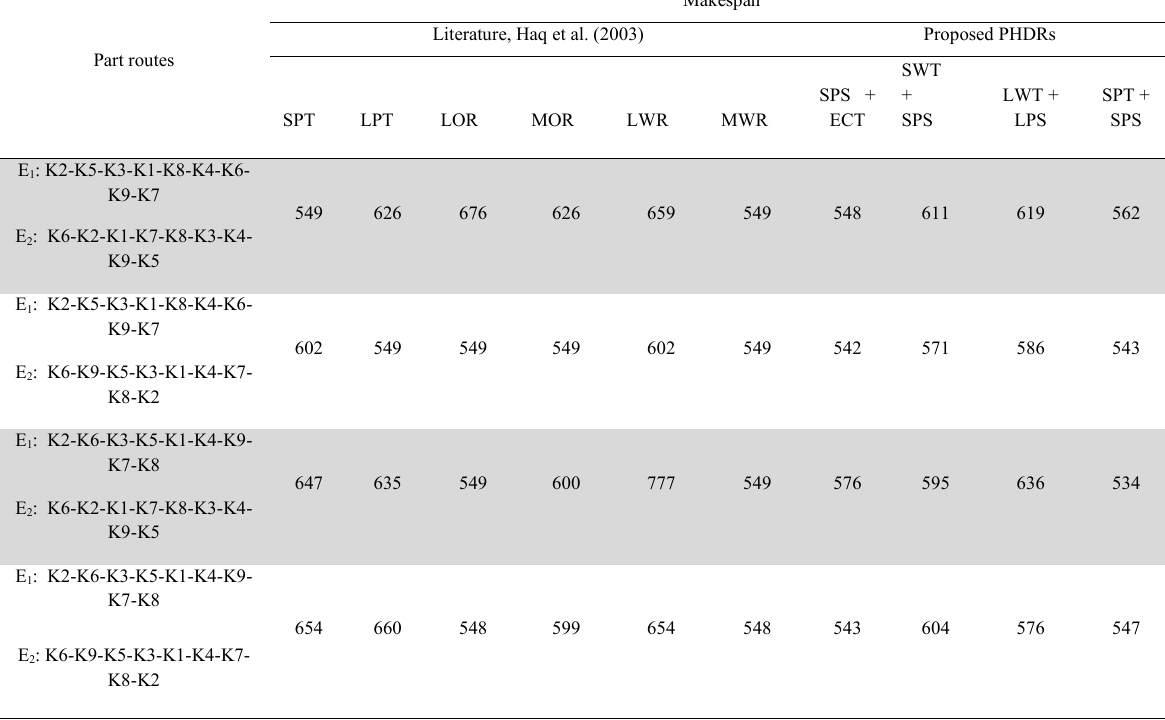
Optimum production plan and makespan according to PDRs and PHDRs